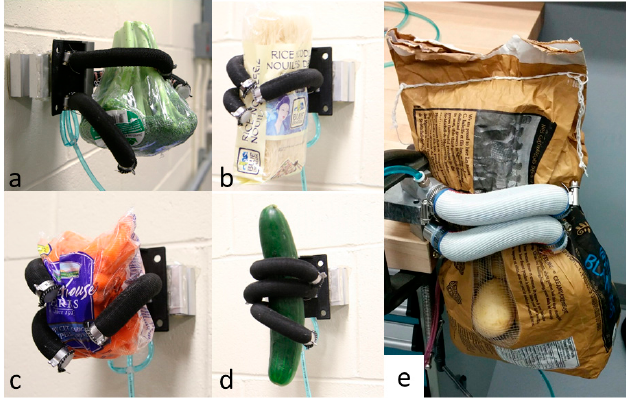
Figure 13. ( a – d ): Small gripper interacting with food items: ( a ) Broccoli; ( b ) rice noodles; ( c ) a bag of baby carrots; and ( d ) cucumber. The pressure is 172 kPa for all tests. ( e ) The large gripper holding a 10-pound potato